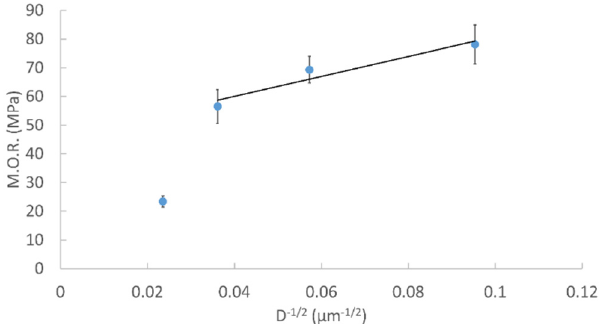
Figure 10. Modulus of rupture of HA as a function of the inverse square root of the grain size over the temperature range from 1000 to 1300 °C.